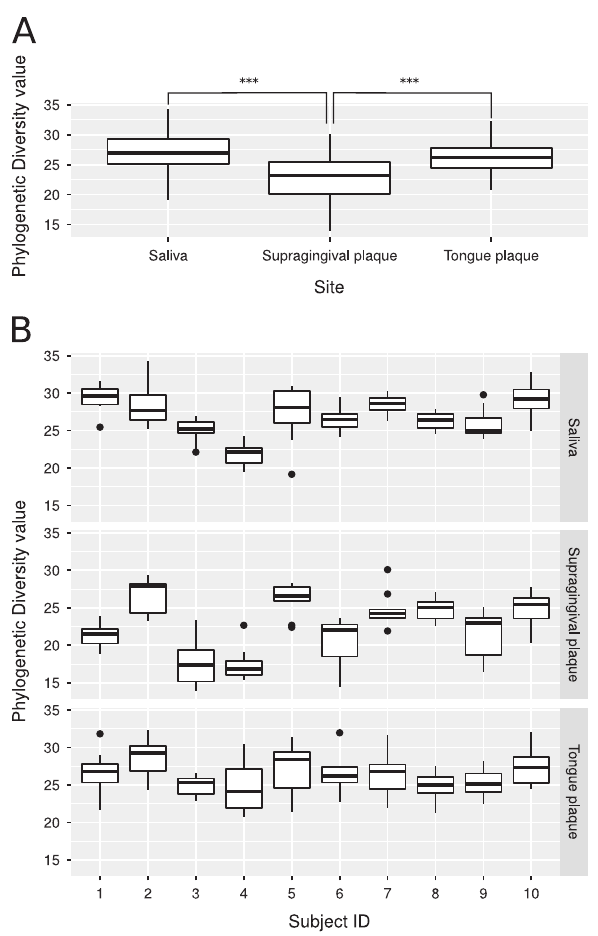
Fig. 2 Boxplots of phylogenetic diversity measures. a PD values grouped by sample site ( *** = signi fi cant at p < 0.001 by pairwise Wilcox test with false discovery rate correction). b PD values grouped by sample site and subject